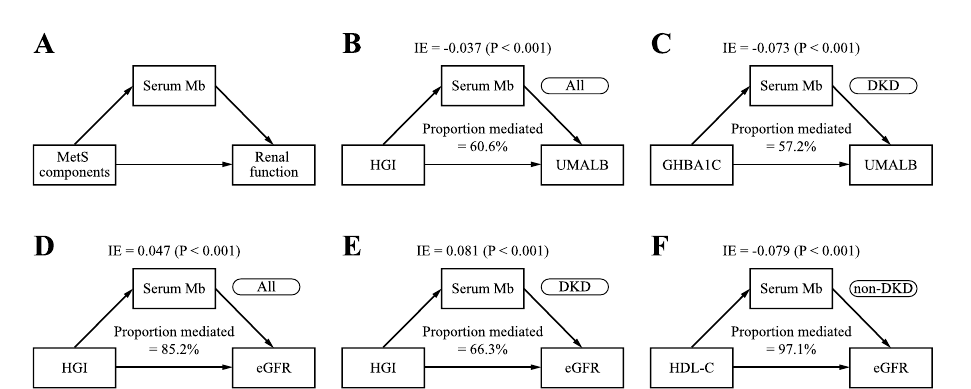
Figure 5. Serum Mb mediates the relationship between MetS components and renal function. ( A ) A directed acyclic graph (DAG) illustrating the mediation process. ( B–F ) Results of causal mediation analysis of 5 significant indirect effects (IE) for serum Mb in all eligible patients, DKD or non-DKD subgroups. ( B,C ) significant IE seen in all eligible patients and DKD subgroup using UMALB as an indicator of renal function. ( D,E,F ) Significant IE seen in all eligible patients, DKD and non-DKD subgroups, respectively, using eGFR as an indicator of renal